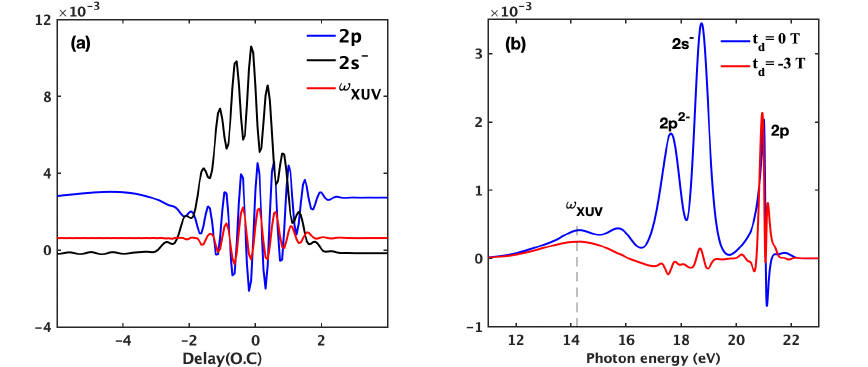
Figure 2. The delay-dependent absorption signals ( a ) and absorption spectrum ( b ) extracted from Figure 1b. The absorption signals of 2p, 2s − , and ω X are represented by the blue, black, and red curves in Figure 2a respectively. Figure 2b is the absorption spectrum for two delays: blue curve for t d = 0 T and red for t d = − 3 T